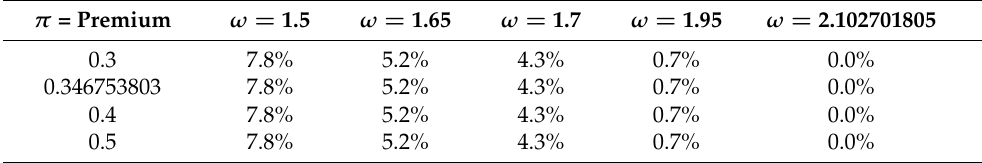
Table 5. Probabilities of ruin for several values of ω and π . π = Premium ω = 1.5 ω = 1.65 ω = 1.7 ω = 1.95 ω =